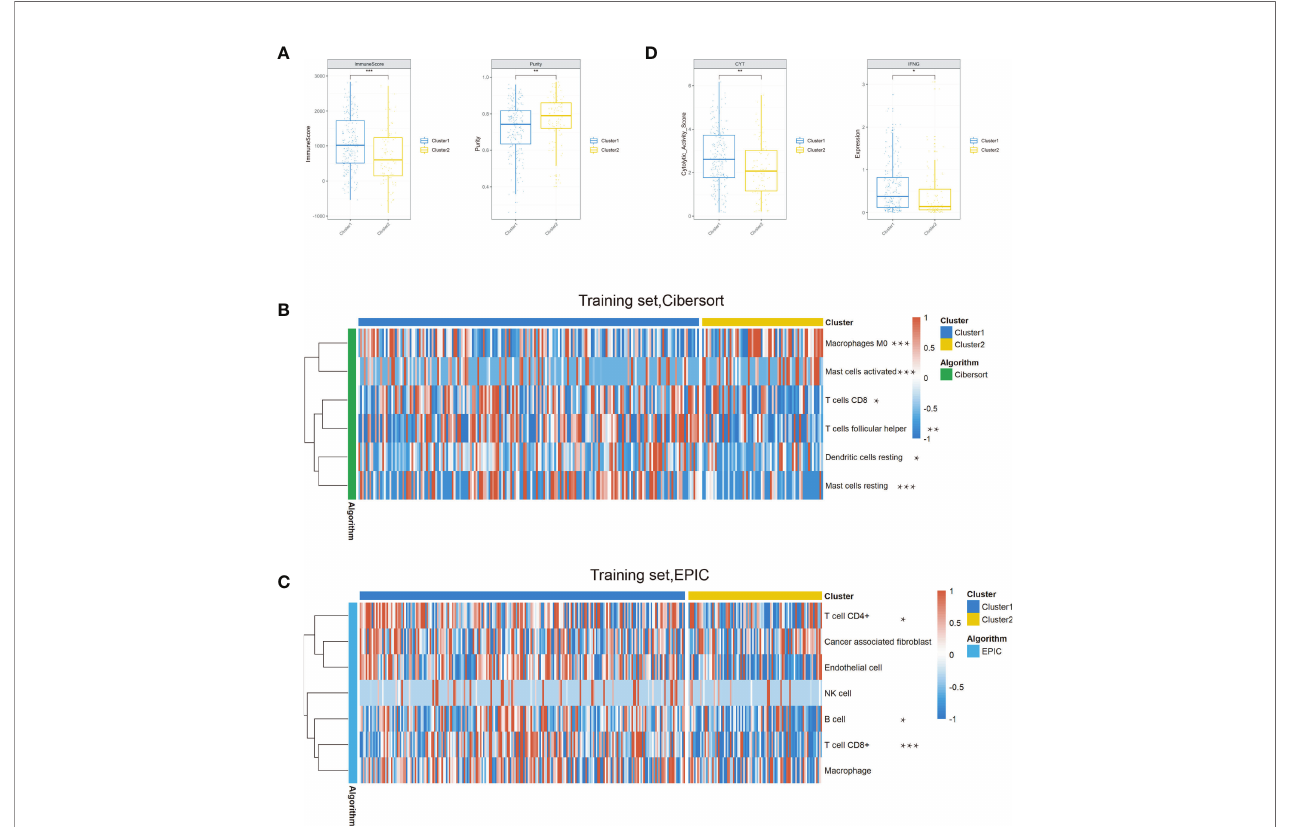
FIGURE 4 | Comparison of the immune conditions and TME between the two clusters in the training set. (A) Cluster 2 occupied a lower immune score and a higher purity than cluster 1. (B) Composition of the six signi fi cantly differential immune cells between the two clusters based on the CIBERSORT algorithm. (C) The Epic algorithm illustrated the immune cell difference between the two clusters. (D) The CYT score and IFNG expression signi fi cantly decreased in cluster 2 (* P < 0.05, ** P < 0.01, *** P <